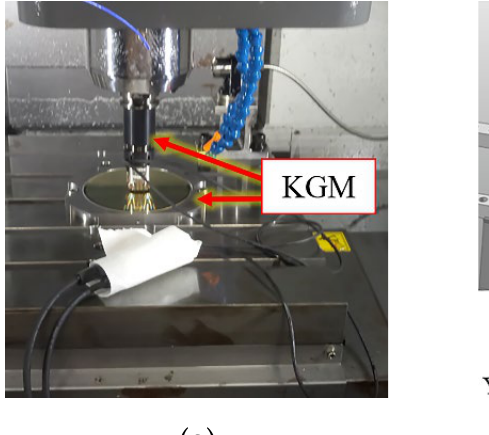
Figure 18. Comparison between measured and simulation torque. ( a ) ( b ) Figure 19. Comparison between measured and simulation result: ( a ) line–curve hybrid trajectory with 50 times the error; ( b ) x - and y -axis contour error.